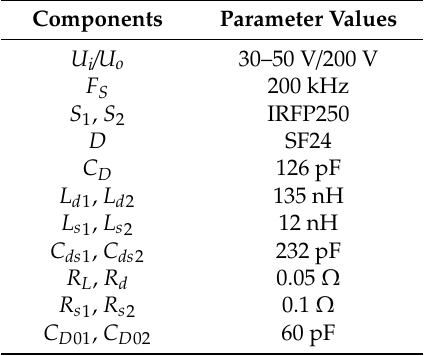
Table 1. Parameter values of devices.